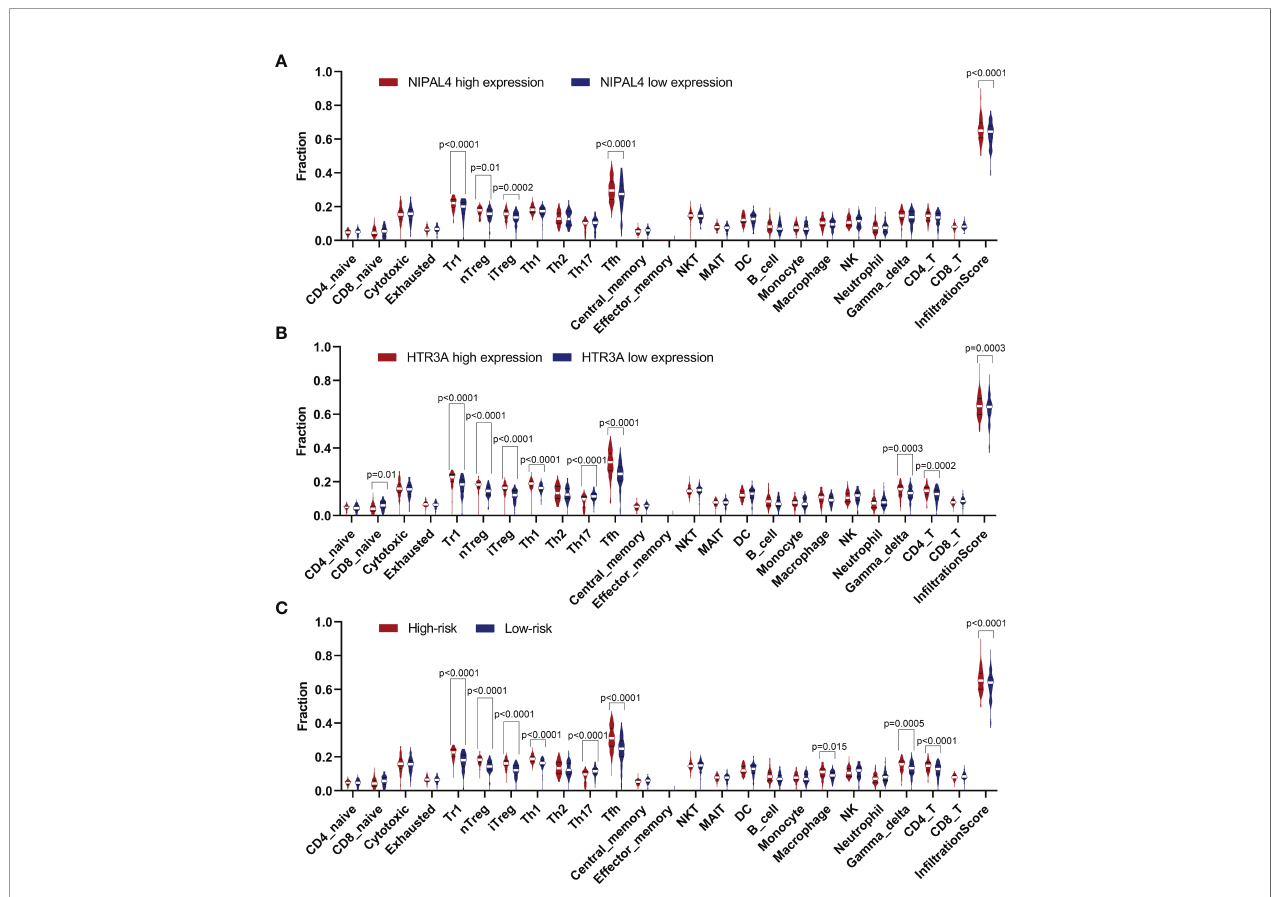
FIGURE 10 | Violin plot showing the compression of each immune cell type in the low/high NIPAL4 groups (A) , low/high HTR3A groups (B) and low/high risk groups (C) . The high-risk/HTR3A/NIPAL4 groups had a higher degree of immune cell in fi ltration ( p < 0.05), suggesting that the risk score, HTR3A and NIPAL4 are involved in the prognosis of BRAF-mutated PTC by interfering with immune